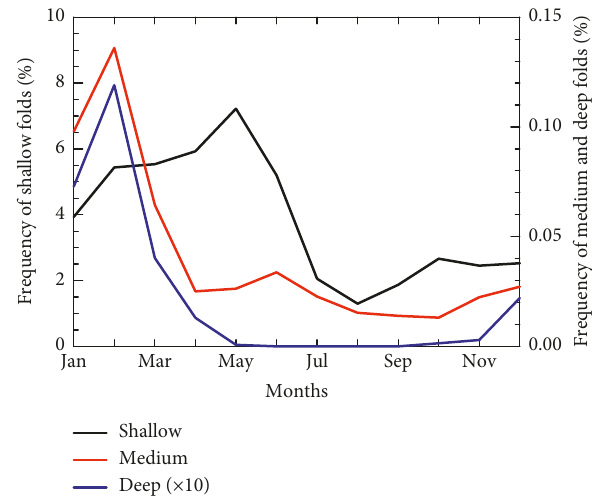
Figure 2: Seasonal cycles of regionally averaged frequencies (%) of shallow (black line), medium (red line), and deep (blue line) tropopause folds over the TP (25–40 ° N, 70–105 ° E) during 1979– 2018. The values for deep folds have been multiplied by a factor 10.